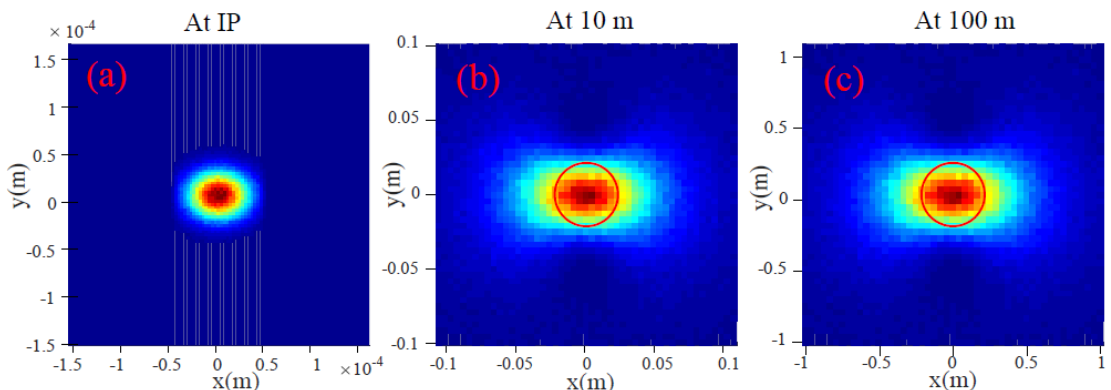
Figure 13. Photon intensity on a screen perpendicular to the electron beam. ( a ): at the interaction point (IP); ( b ): at 10 m from the source; ( c ) at 100 m. The red circle delimits the region inside the θ = 1/ γ acceptance